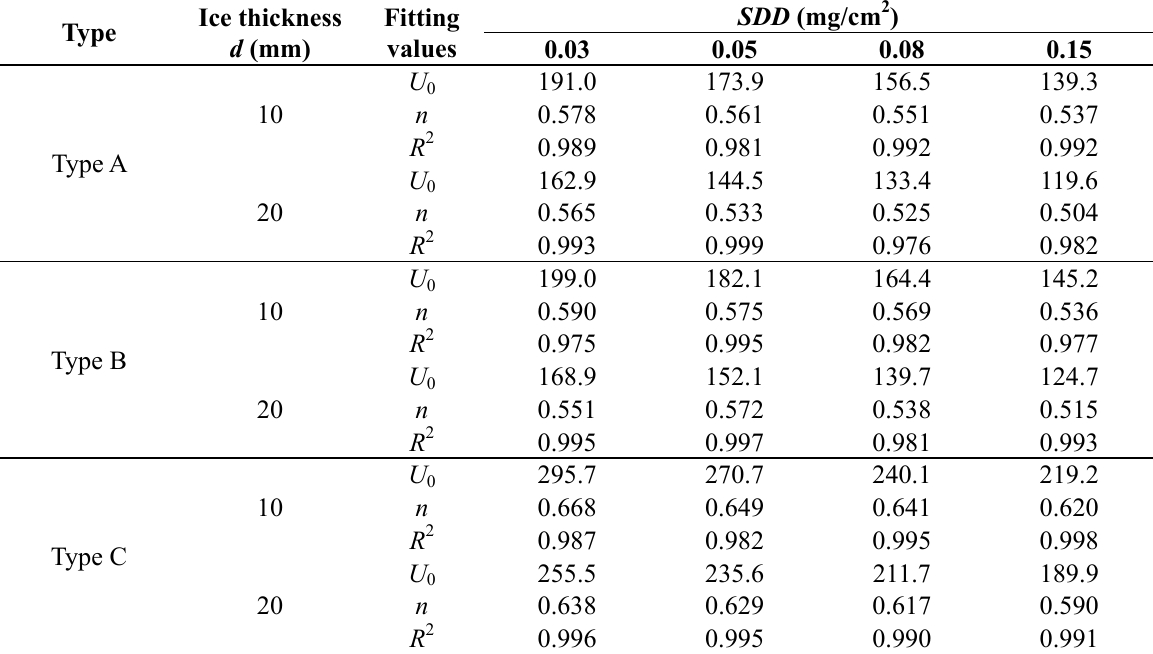
Table 8. Fitting values of U